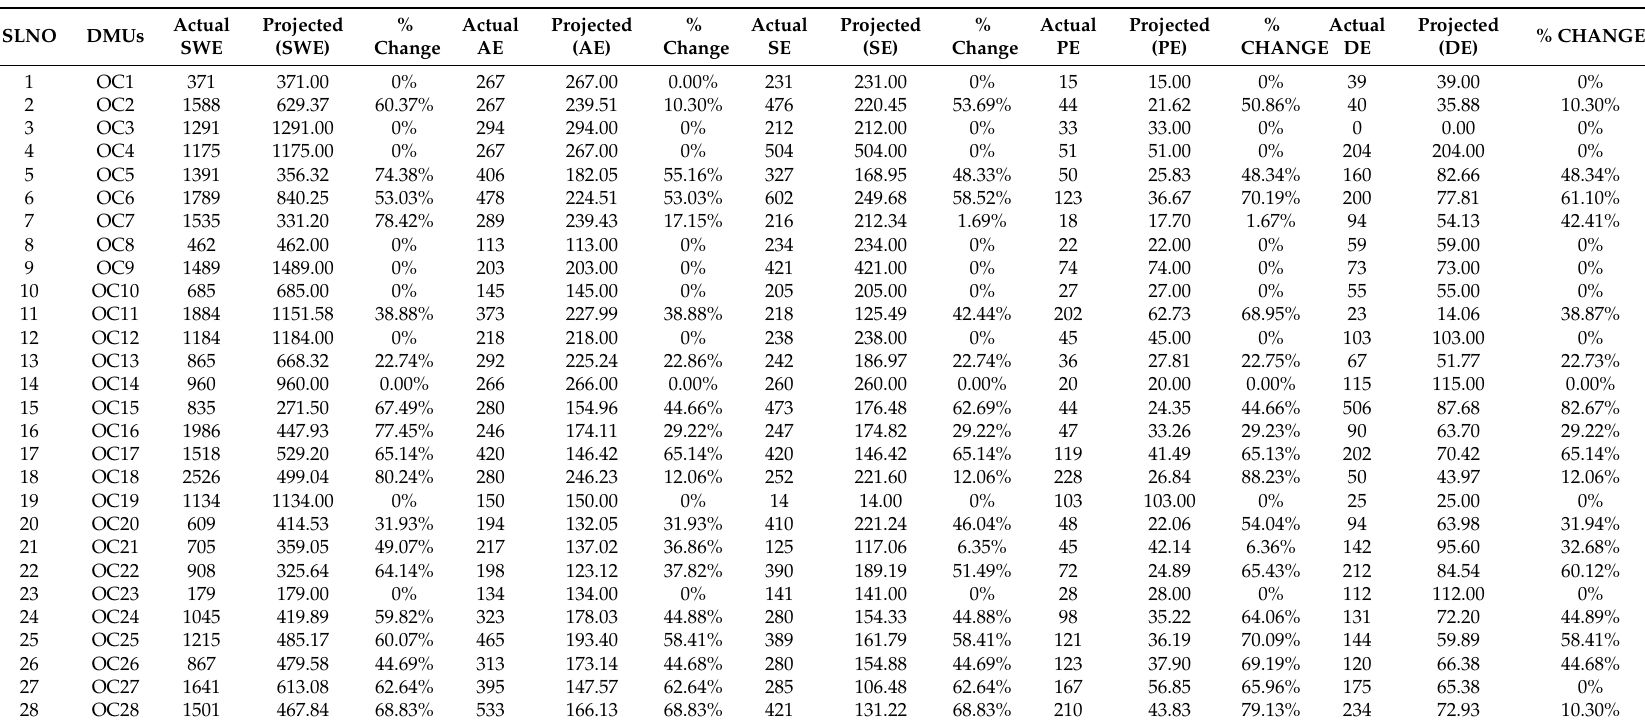
Table A4. Comparisons between actual and projected value with percentage change of input variables of opencast mines using VRS